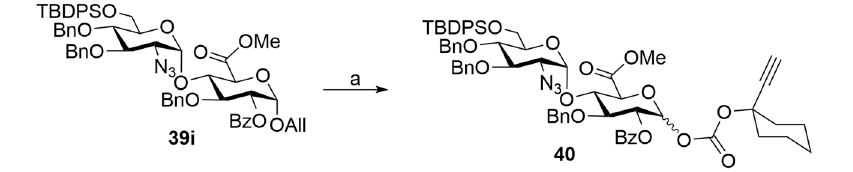
Fig. 5 Synthesis of D – E disaccharide donor. Reagents. a (i) PdCl 2 , MeOH – CH 2 Cl 2 (3:1), 25 °C, 4 h, 95%, (ii) 24 , DMAP, CH 2 Cl 2 , 25 °C, 3 h,